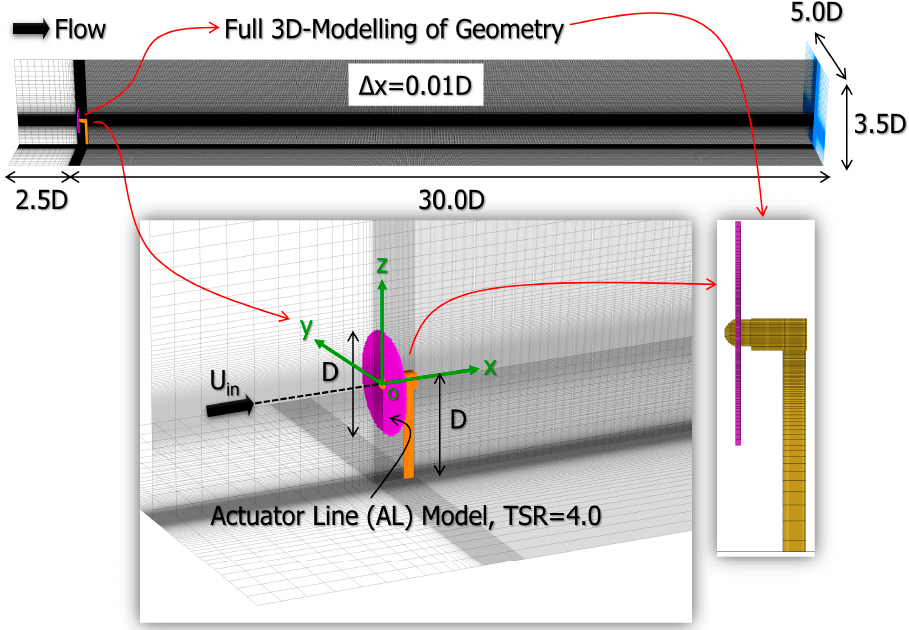
Figure 12. Calculation domain and grid set in this research.